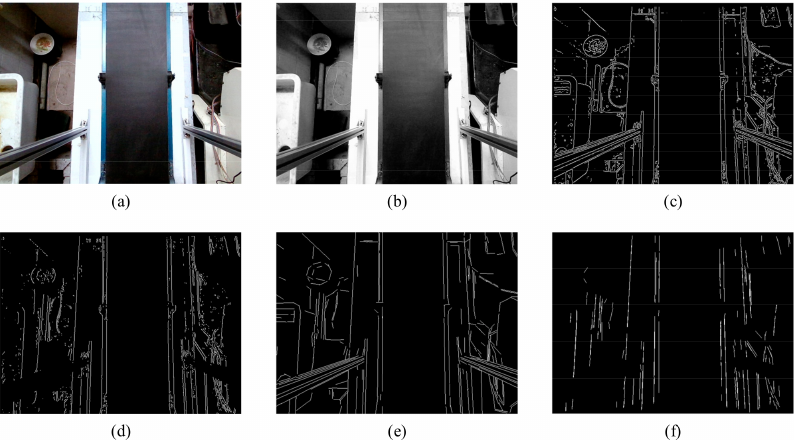
Figure 19. Comparison of actual image processing results. ( a ) Test image; ( b ) Gray image; ( c ) Edge detection image before angle suppression; ( d ) Edge detection image after angle suppres-sion; ( e ) Line segment information by original LSD; ( f ) Line segment information by IP